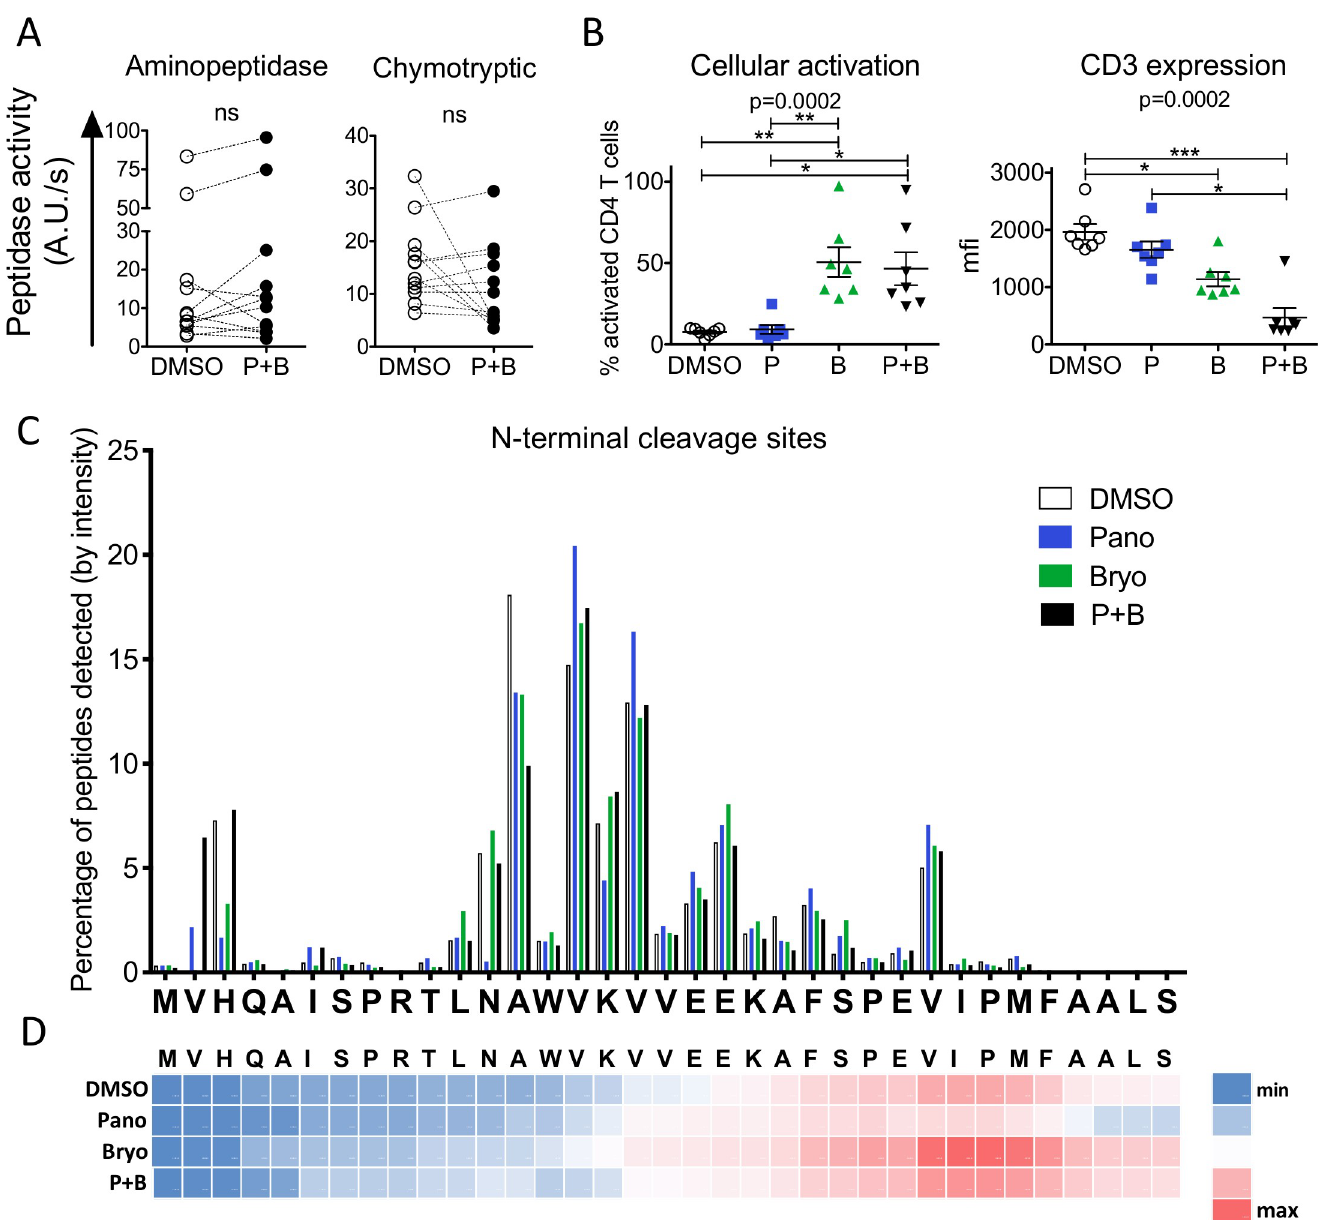
Fig 5. Combined Bryostatin and Panobinostat treatment of CD4 T cells changes HIV peptide degradation patterns. A. Aminopeptidase (left) and proteasomal chymotryptic (right) hydrolytic activities in paired DMSO- (open circles) and Panobinostat+Bryostatin-treated (filled circles) primary CD4 T cells measured at 48 h post-treatment. n = 12 healthy donors. Wilcoxon matched-pairs signed-rank t tests. ns: not significant. B. The surface expression of CD3 (right) and CD25 and CD69 (left) was monitored by flow cytometry in primary CD4 T cells at 48 h post treatment with DMSO (open circles), Panobinostat (blue squares), Bryostatin (green triangles), a combination of Panobinostat+Bryostatin (black inverted triangles) (n = 7 healthy donors). One-Way ANOVA Kruskal-Wallis tests were performed on the 4 groups and the overall p-value is reported, Dunn’s Multi-comparison test was calculated and the pairs that statistically differed are indicated with a bar. � p < 0.05, �� p < 0.01, ��� p < 0.001. C. Cleavage patterns of p24-10-35m after degradation in extracts from DMSO- (open bars), Panobinostat- (blue), Bryostatin- (green) and combination Panobinostat+Bryostatin-treated (black) primary CD4 T cells extracts at 120 min, showing the relative amount of fragments starting (N- terminus cleavage site) at each residue. Results shown for a representative experiment. D. Heat map representing the relative amount of 8–11 aa peptides containing each aa. Each row represents an LRA-treatment. One representative experiment is shown.